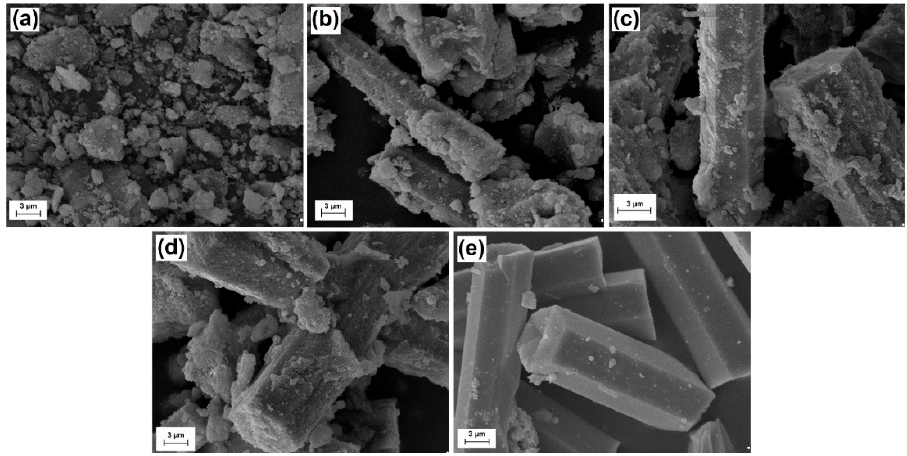
Figure 4. SEM images for: ( a ) TiO 2 ; ( b ) Ti8Mo2; ( c ) Ti5Mo5; ( d ) Ti2Mo8; ( e ) MoO 3 .